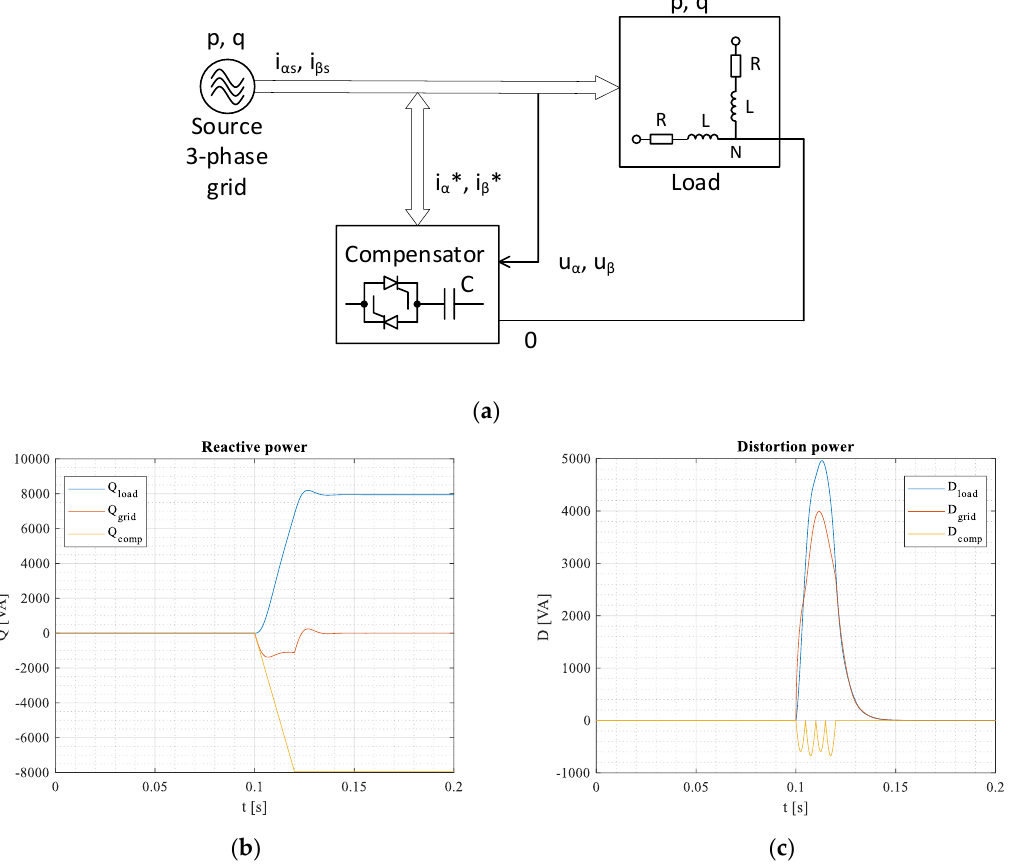
Figure 31. Using switched capacitors ( a ) for compensating reactive blind power ( b ) under linear RL load and distortion power ( c ).